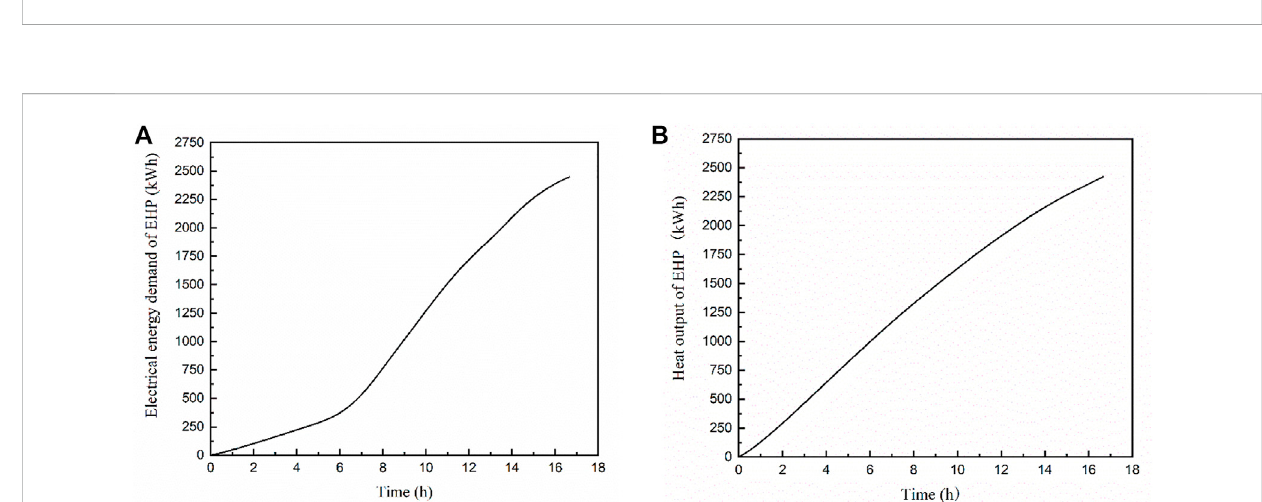
FIGURE 12 Simulation heating process of a triple cogeneration system.